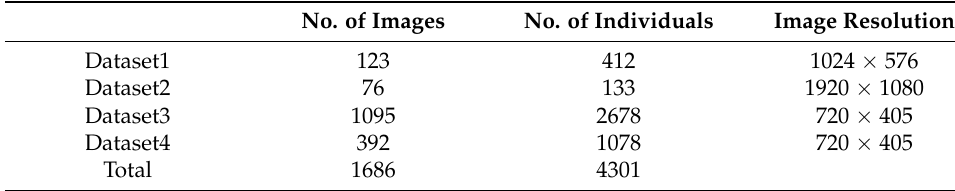
Table 1. Details of image datasets in this study.